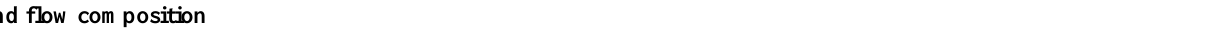
Table A2. Assumptions used to design and solve the model. Units, equations and flow